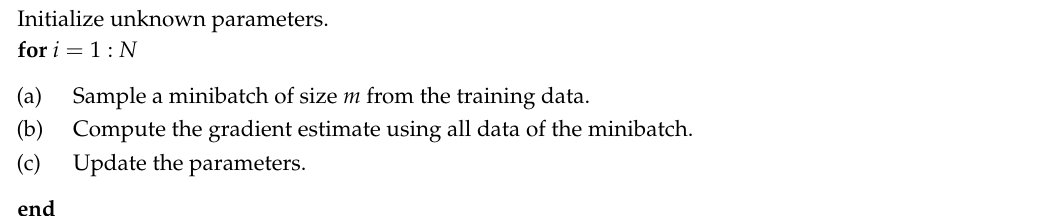
Algorithm 2 . Minibatch gradient descent algorithm: Algorithm of minibatch stochastic gradient descent